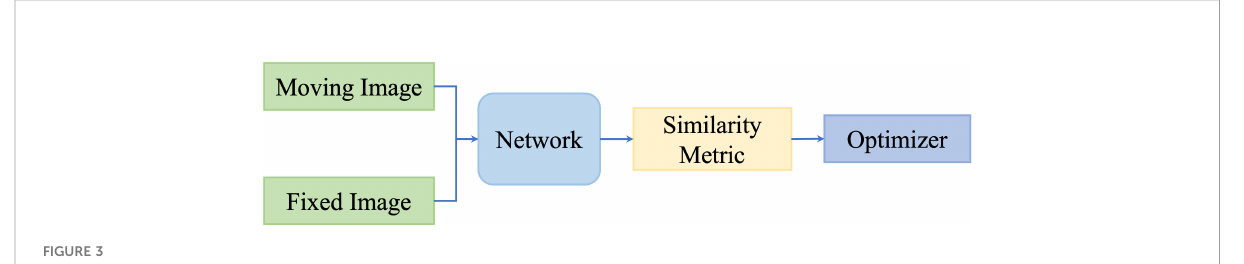
FIGURE 3 Illustration of deep similarity metric-based registration